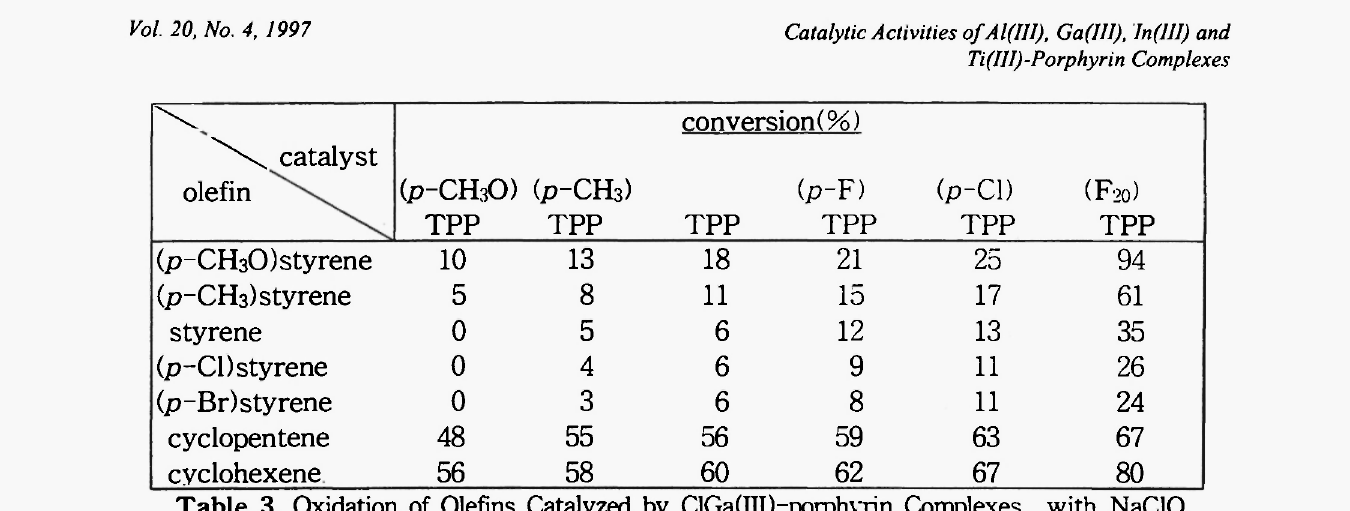
Table 3. Oxidation of Olefins Catalyzed by ClGa (III )-porphyrin Complexes with NaClO.